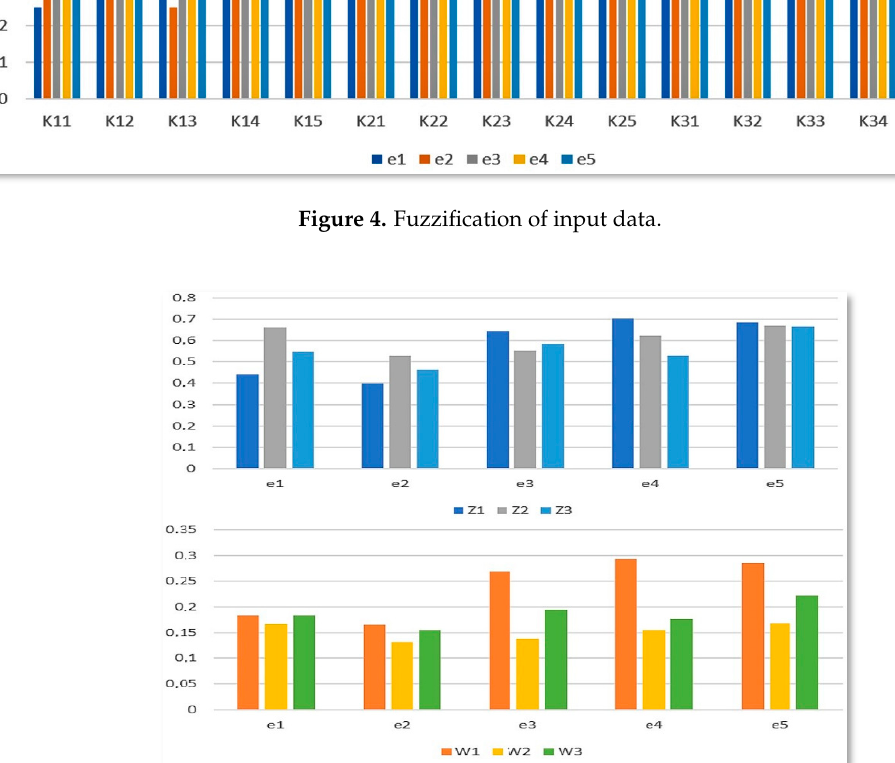
Figure 4. Fuzzification of input data.